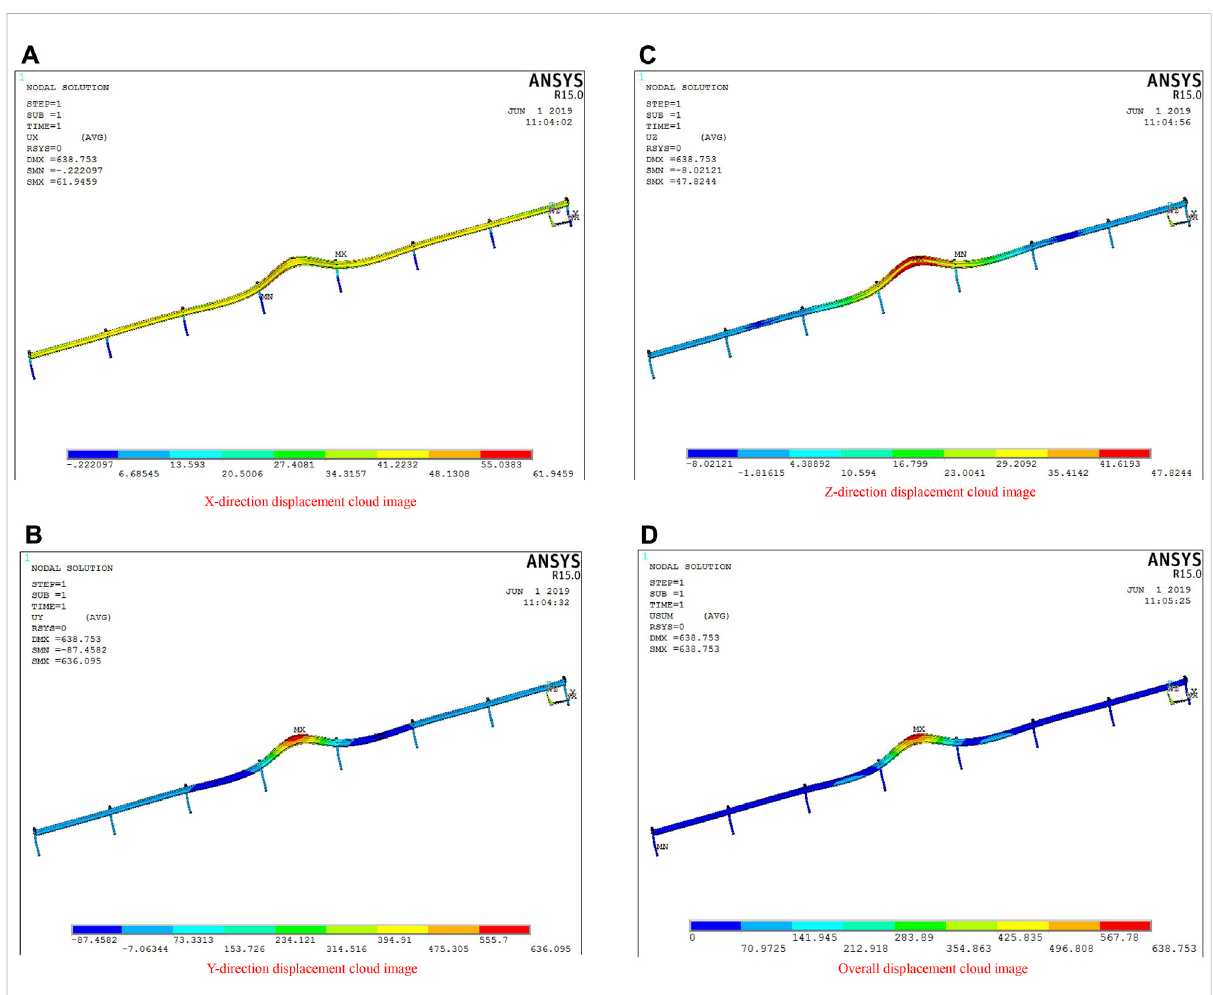
FIGURE 10 Displacementclouddiagramofathree-wave beamsteelguardrail(impactedbythe25-textra-largebusatthespeedof85 km/hfromanangle of 20 ° , the soil-embedded guardrail post). (A) : X-direction displacement cloud diagram of three-wave beam steel guardrail. (B) : Displacement cloud diagram of three-wave beam steel guardrail in Y direction. (C) : Z-direction displacement cloud map of three-wave beam steel guardrail. (D) : The overall displacement cloud diagram of the three-wave beam steel